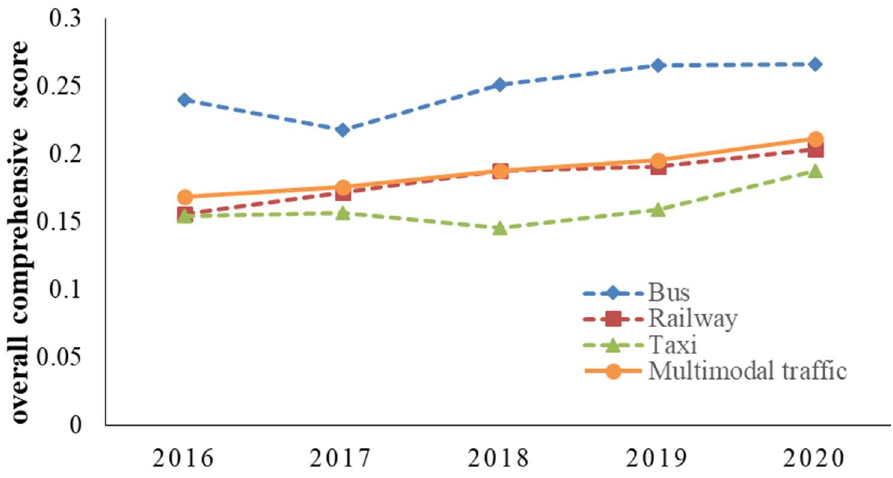
Figure 1. The overall comprehensive development level of buses, rail transit, and taxis in 36 cities.